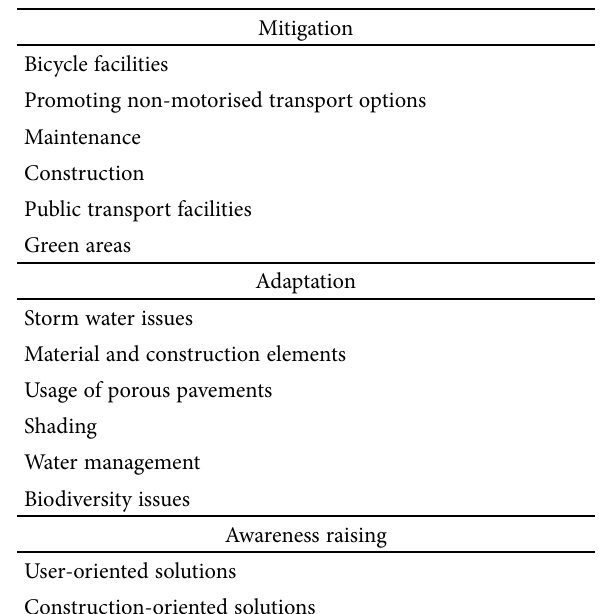
Fig. 1. Location of the examined main